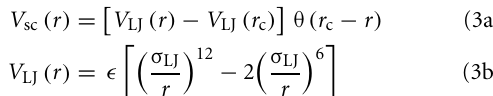
Table 1 | Interaction potentials of the referenced model and corresponding